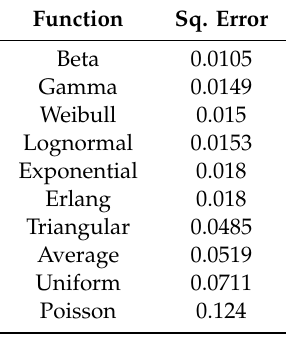
Table 4. Error table for cycle time goodness-of-fit tests in the angiography room.